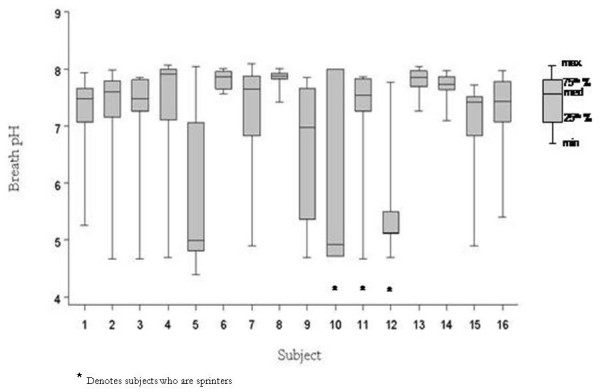
Pre-exercise breath pH by subject (n = 16 subjects, 144 samples), with sprinters denoted by asterisks.